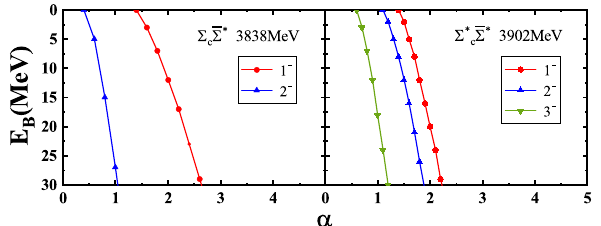
Fig. 4 Binding energies of isoscalar bound states from the charmed- antistrange interactions with the variation of α in single-channel calcu- lation